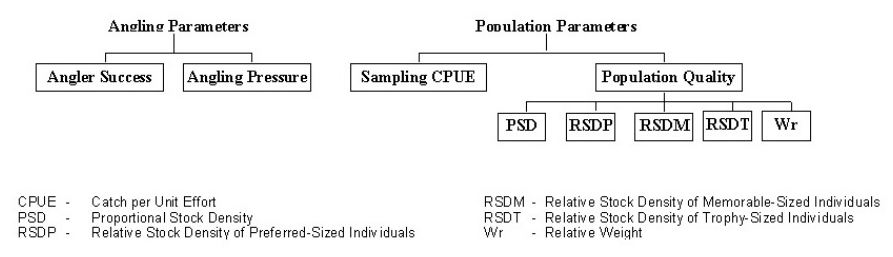
FIGURE 1. Parameters used to calculate the sport fishing